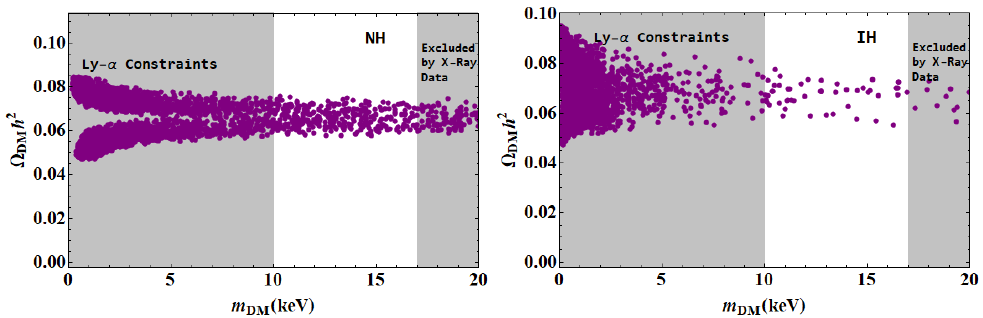
Figure 2 . Decay rate of the lightest sterile neutrino as a function of DM mass for normal hierarchy as well as inverted hierarchy.